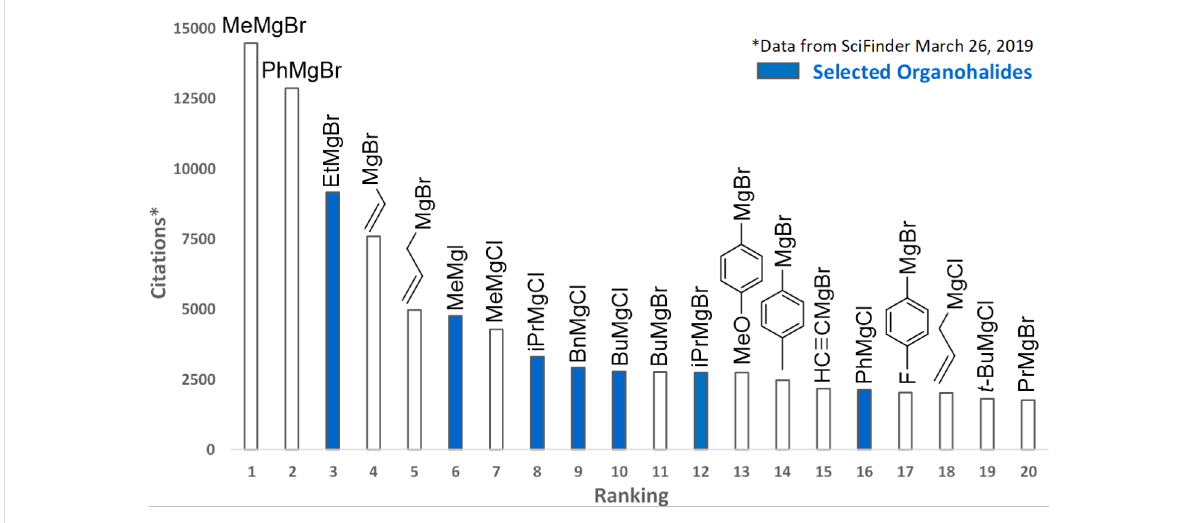
Figure 2: Ranking of the 20 most cited Grignard reagents (SciFinder March 26, 2019).